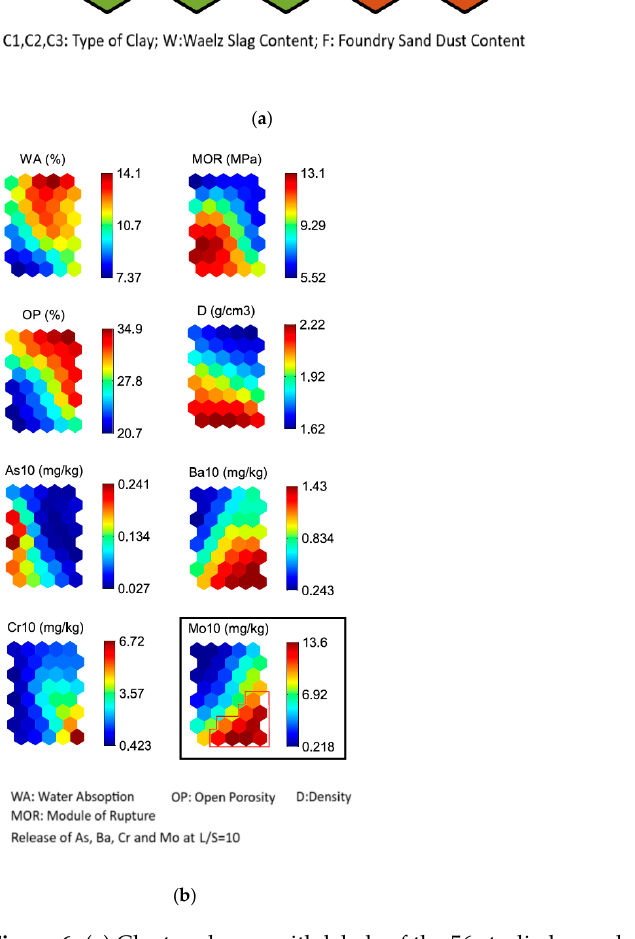
Figure 6. ( a ) Clustered map with labels of the 56 studied samples from laboratory, pilot-plant and industrial clay mixtures with WS incorporation. ( b ) Component planes of the SOM for the eight input variables with Mo highlighted along with neurons that exceed non-hazardous landfill limits.